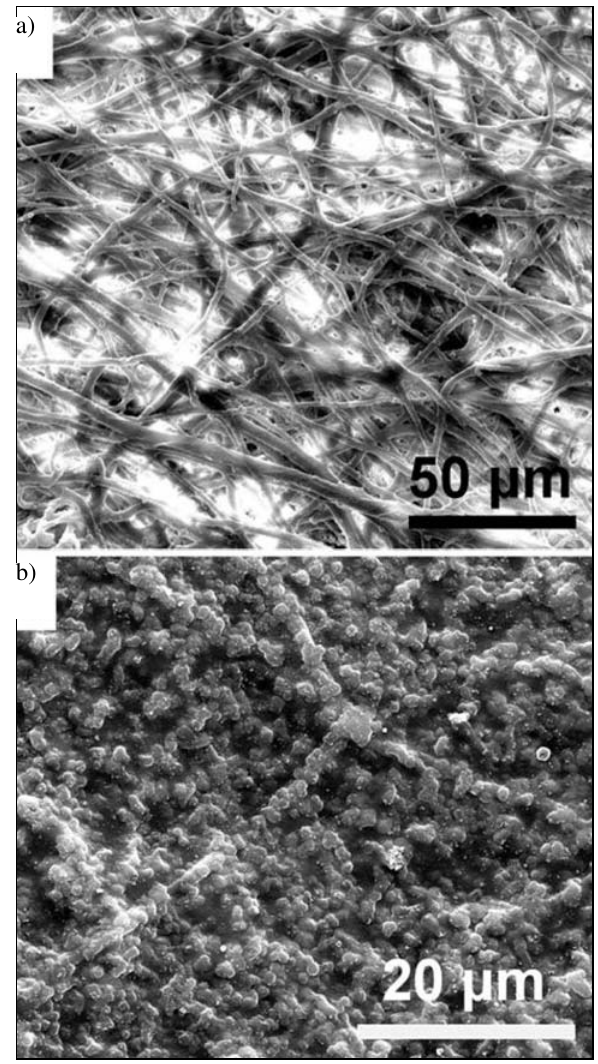
Figure 1. SEM images of (a) ESM and (b) MnO were 50 μm and 20 μm,